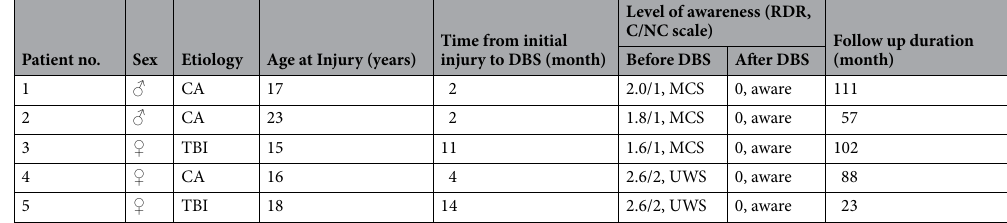
Table 1. Demographic and clinical characteristics of consciousness improved patients after DBS. CA cardiac arrest, TBI traumatic brain injury, RDR rappaport disability rating scale, C/NC coma/near coma scale, UWS unresponsive wakefulness syndrome, MCS minimally conscious